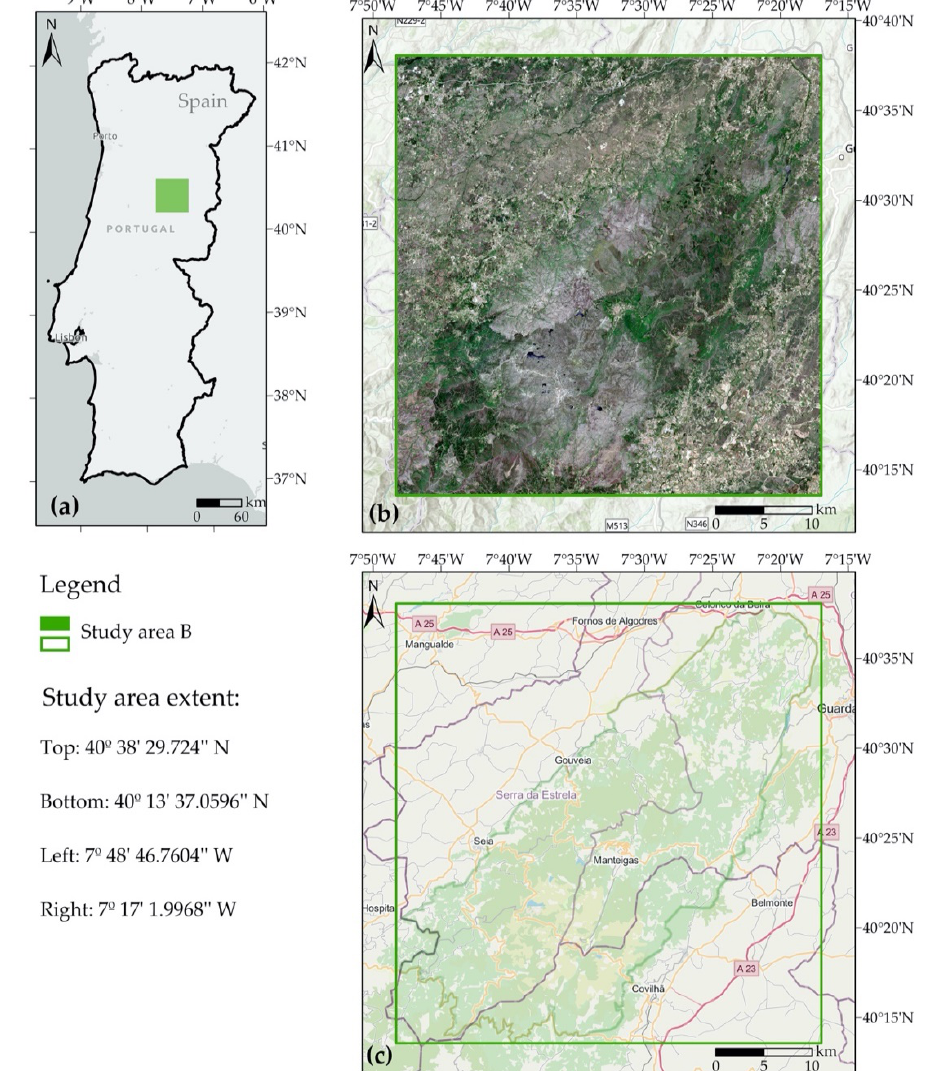
Figure 2. Study area B: ( a ) Location within continental Portugal, ( b ) Sentinel-2 satellite image of the study area collected in 19 June 2018, ( c ) OSM data available in the study area (OSM basemap provided by ESRI).